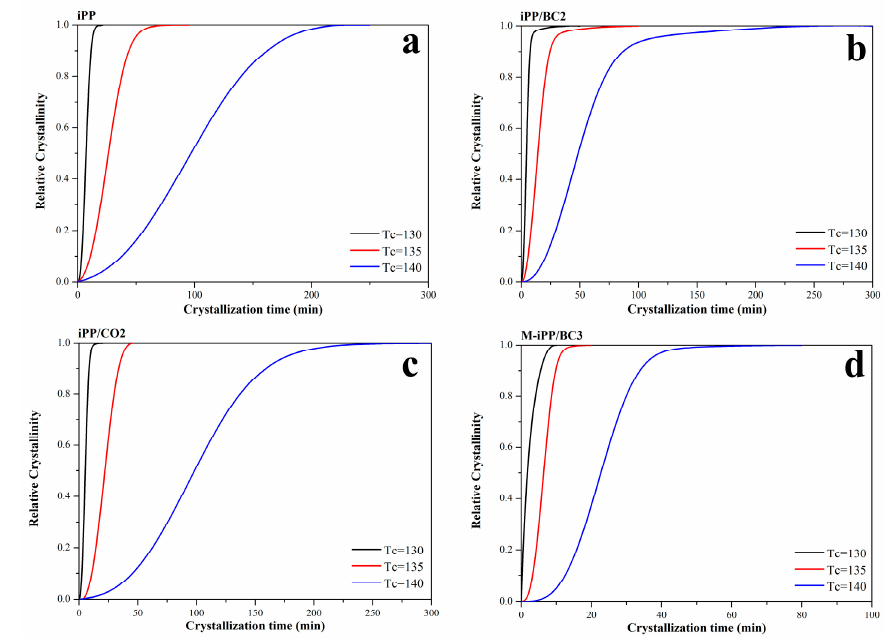
Figure 3. Relative degree of crystallinity with time of iPP/BC composites. ( a ) iPP ( b ) iPP/BC2 ( c ) iPP/CO2 ( d ) M-iPP/BC3